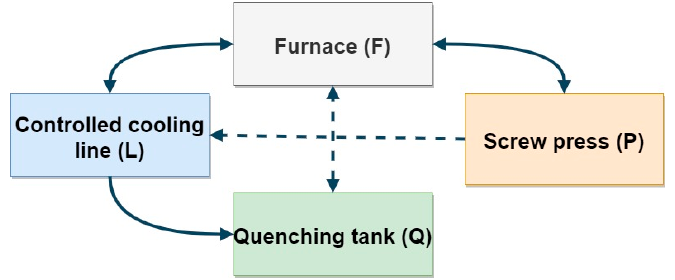
Figure 7. The flowchart of a test station for the processing of thermoplastic.